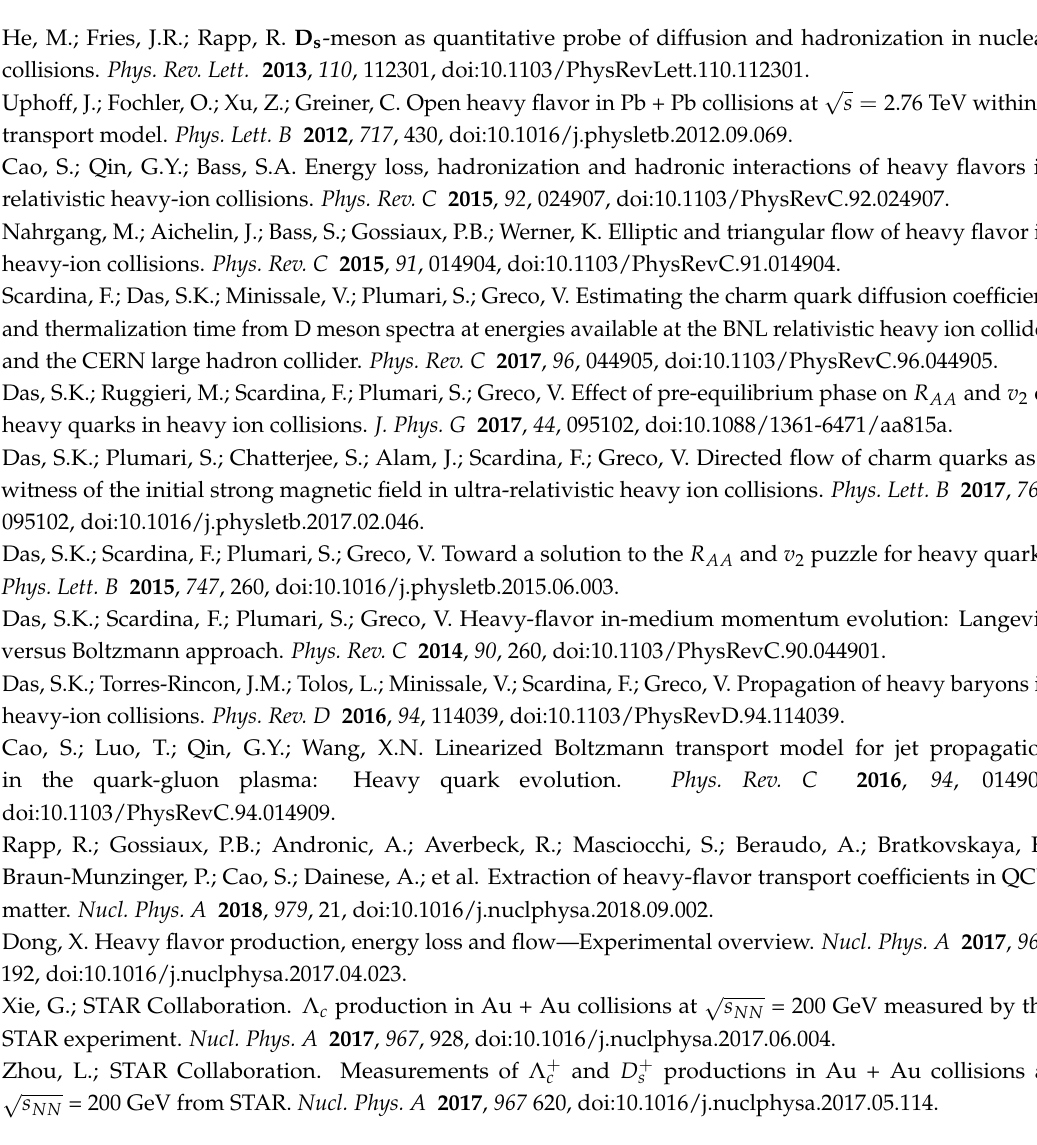
√ s = 2.76TeV (right panel). √ s =